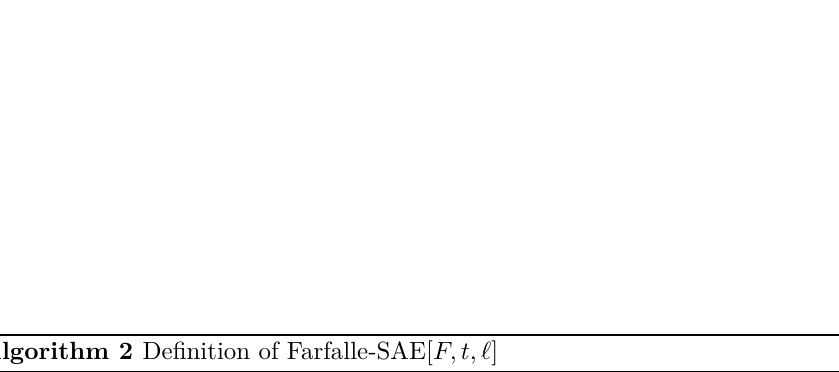
Algorithm 2 Definition of Farfalle-SAE[ F, t, ‘